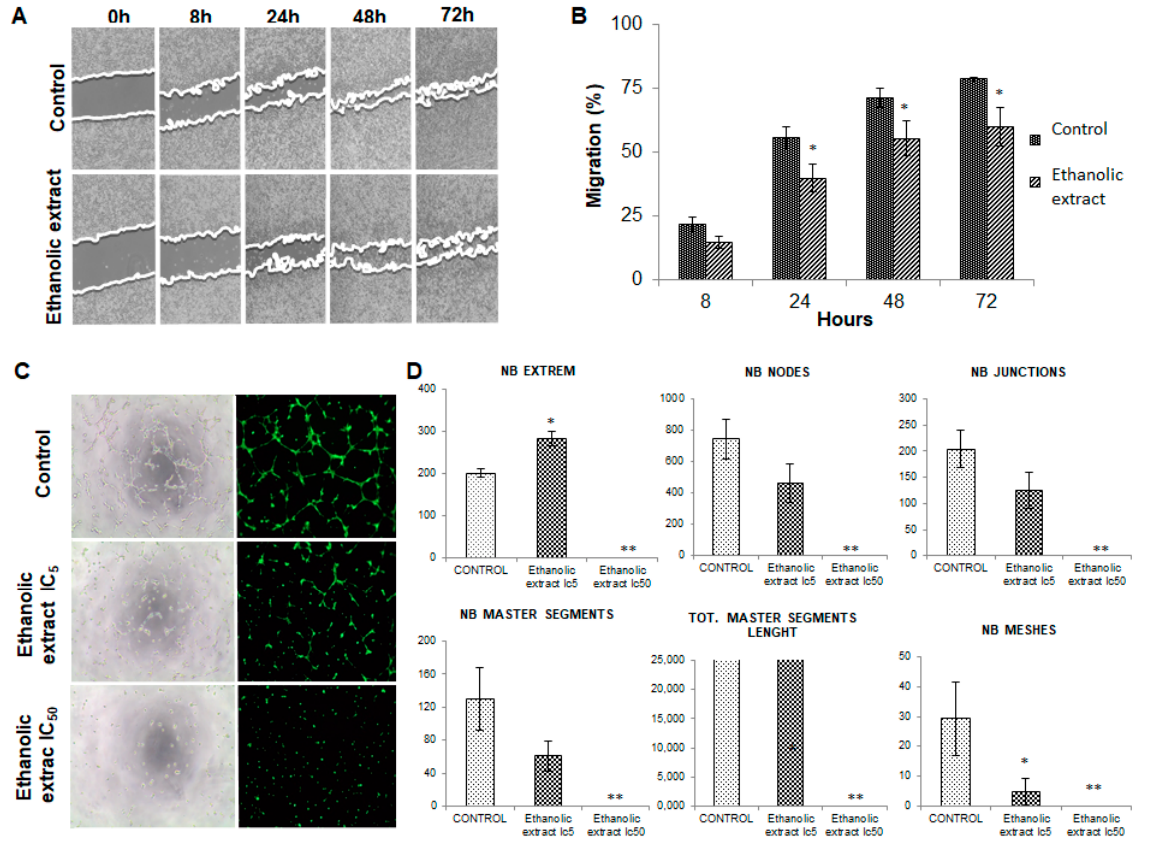
Figure 4. Analysis of migratory capacity and antiangiogenic effect. ( A ) Representative images from T84 colon tumor cell migration at different times (0, 8, 24, 48, and 72 h) after exposure to a subcytotoxic dose (Ic5) of the ethanolic extract of defatted flour from mature seeds of Euphorbia lathyris . ( B ) Graphic representation of the percentage of T84 colon tumor cell migration. Data are presented as mean ± standard deviation of triplicate cultures in each column. * Data with significant differences between treated and non-treated cells ( p < 0.05). ( C ) Representative optical microscopy images of blood vessel formation by human umbilical vein endothelial cells (HUVECs) after exposure to conditioned media obtained from T84 colon cancer cells treated with the ethanolic extract (IC 5 and IC50). Fluorescence microscopy images of blood vessels formation by HUVECs after exposure to the conditioned medium. ( D ) Graphical representation of different angiogenic parameters measured in fluorescence microscopy images, including number of extreme (NB extreme), formation of nodes (NB nodes), number of master segments (NB master segments), total master segments segments length (TOT. master segments length) and number of junctions (NB junctions). EE, ethanolic extracts. Data are presented as mean ± standard deviation of three independent experiments; * p < 0.05 vs. the respective control group, ** p < 0.01 vs. the respective control